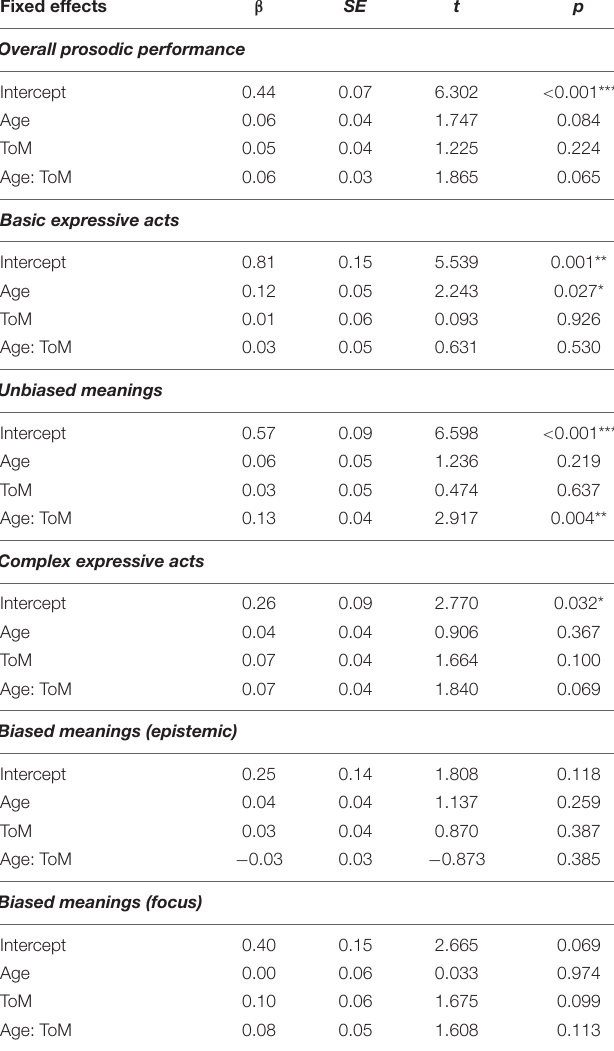
TABLE 3 | Model specification and estimates for the models exploring the relationship between ToM and prosodic abilities (children’s overall prosodic performance and their prosodic performance for specific speech act